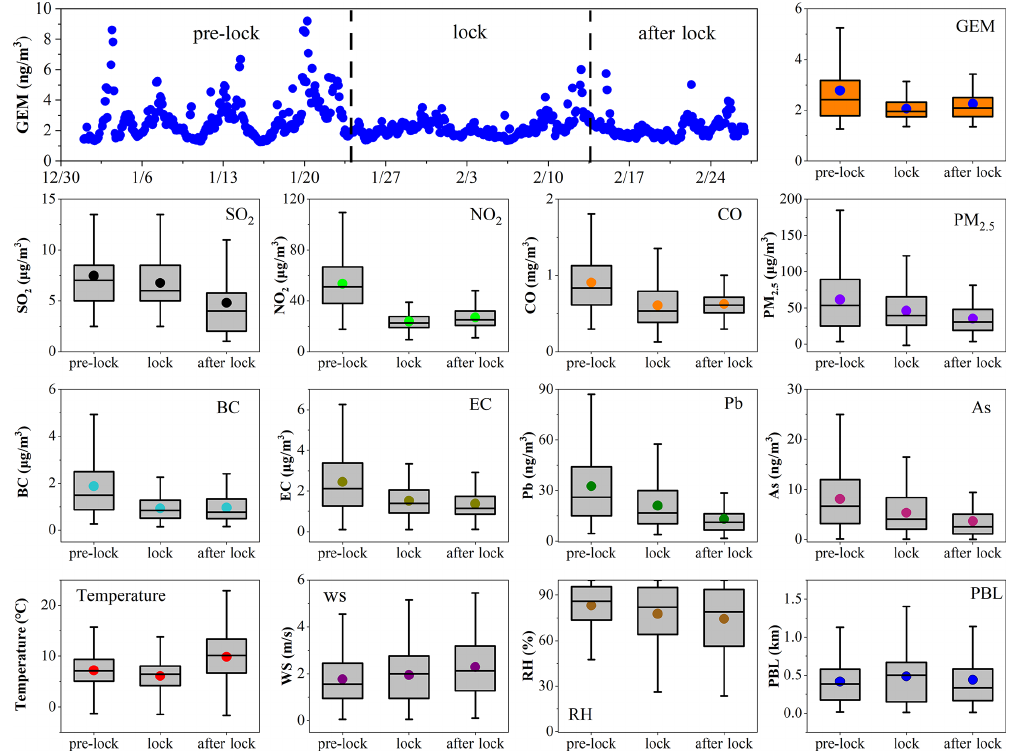
Figure 1. Hourly variations in GEM concentrations from 1 January to 26 February 2020. Box plots of GEM, SO 2 , NO 2 , CO, PM 2 . 5 , BC, EC, Pb, As, and meteorological parameters (temperature, wind speed, relative humidity, and planetary boundary layer height) before, during, and after the lockdown are also